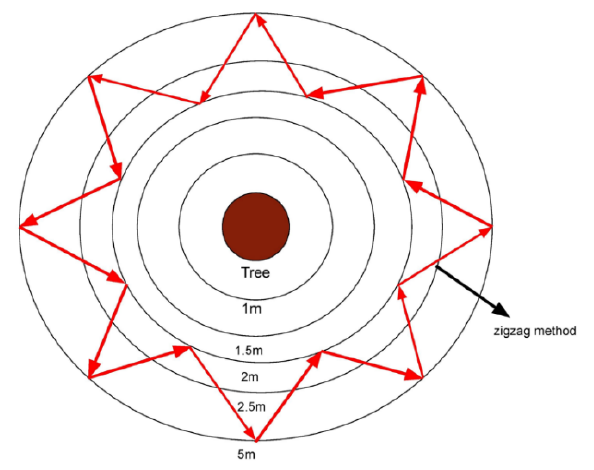
Figure 8. Scanning the tree from five different distances and additionally scanning with zigzag path.